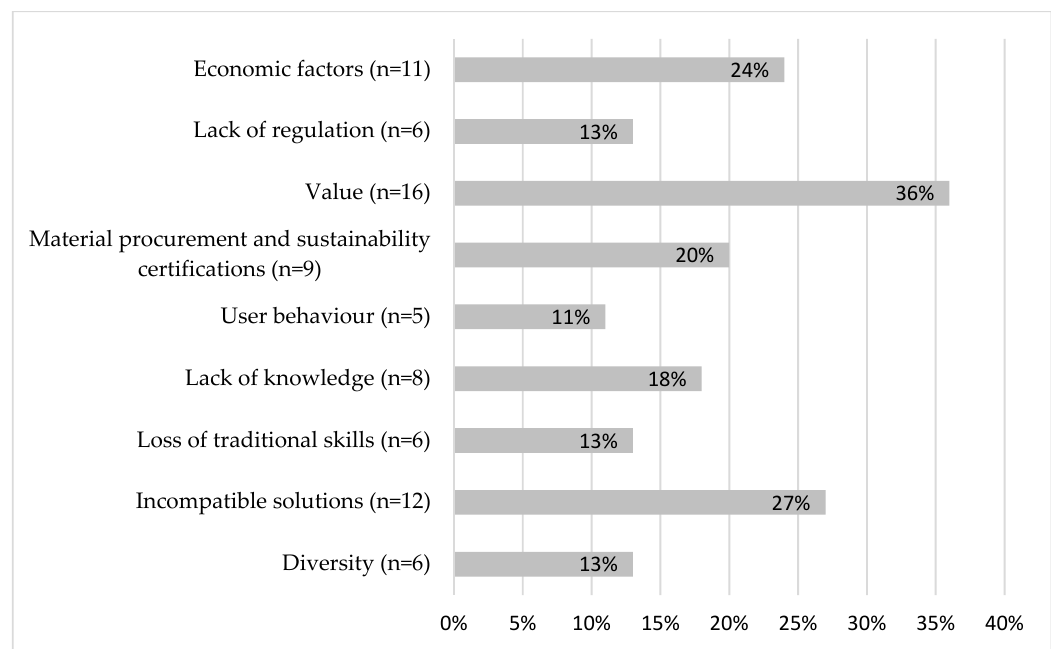
Figure 4. Percentage of interviewees mentioning each barrier ( n is the number of interviewees mentioning the barrier).